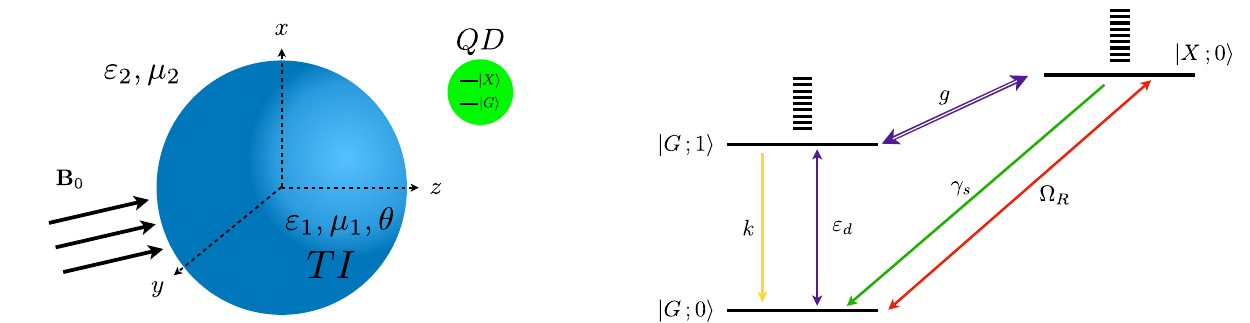
Figure 1. (Left) Schematics of the hybrid plexciton composed of a topological insulator nanoparticle and a semiconductor quantum dot in the presence of an external magnetic field. (Right) TI-QD tower of states 0, 1 , the states are connected by the amplitude ε truncated for m d of the TI electric field, the total decay rate k = of the TI, the coupling strength parameter g , the spontaneous emission rate γ s of the QD and the Rabi frequency (cid:31) R